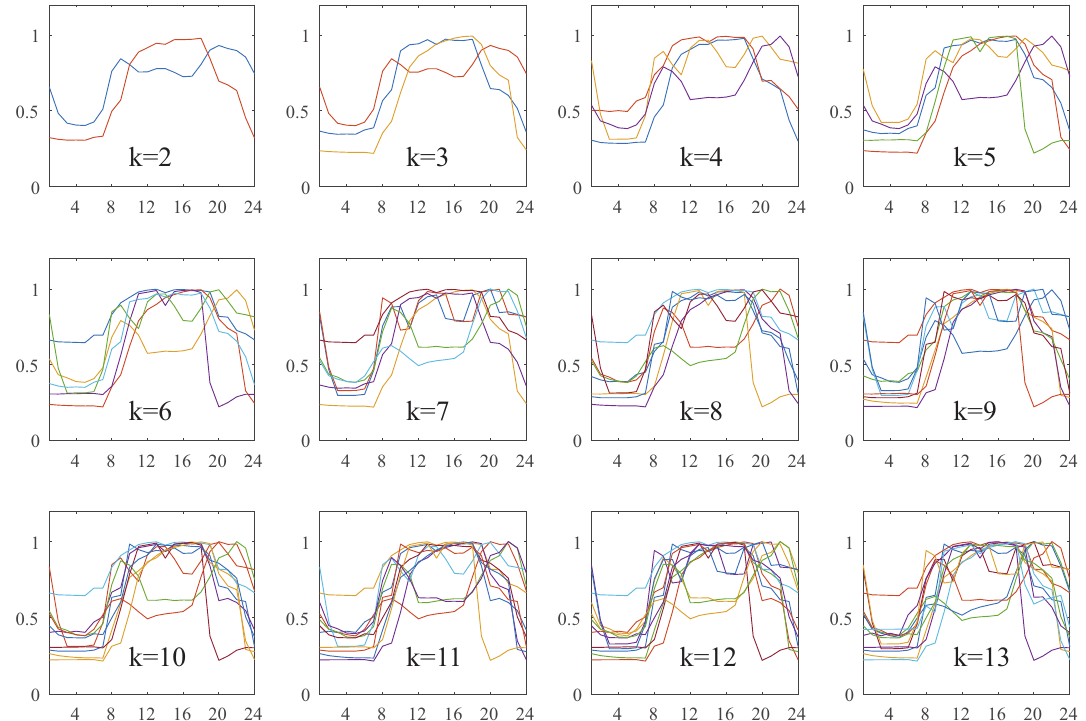
Figure 12. A comparison for the decision maker of k cluster number (commercial area load profiles).